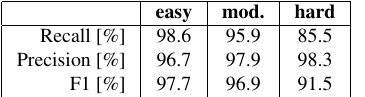
Table 1. Vehicle detection results.